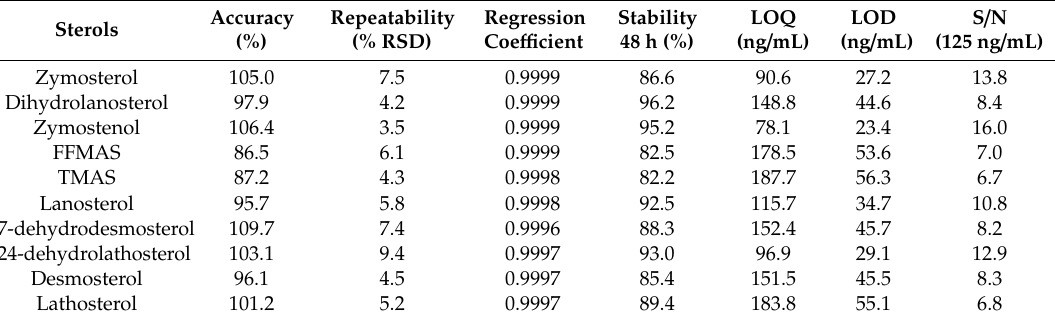
Table 1. Validation data for sterol intermediates for all measured sterols.